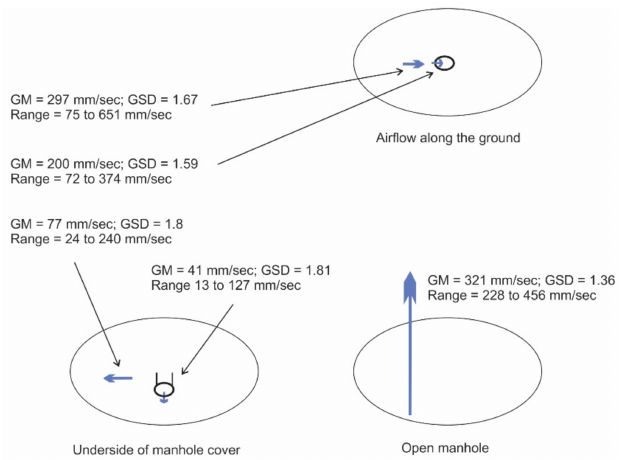
Figure 9. Summary of air movement along the ground and inside the isolated subsurface structure. GM is geometric mean; GSD is geometric standard